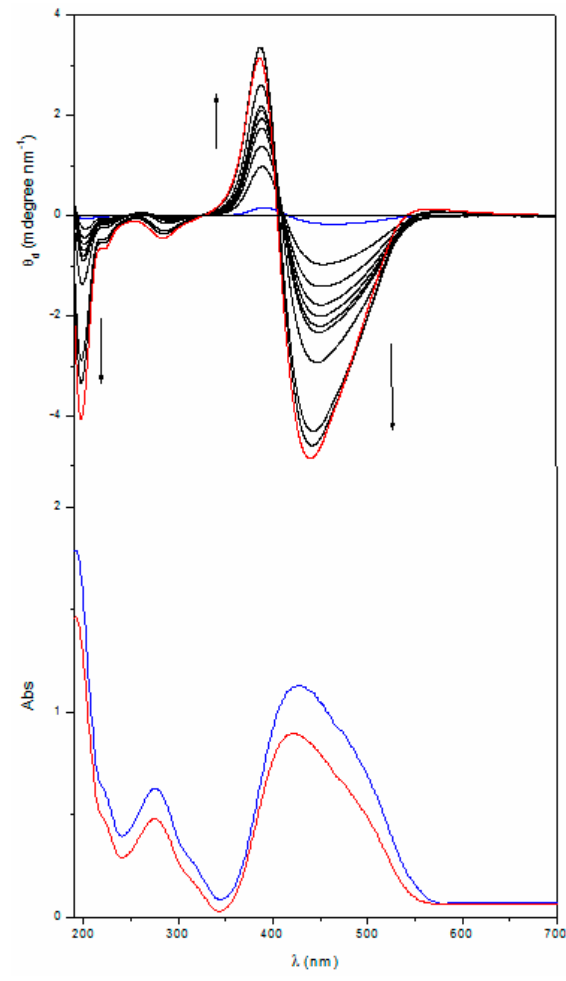
Figure 4. CD (up) and UV-vis (bottom) spectra of a 145 nm thick film of poly[( R )- MAP-C ] before (—) and after annealing at 200 °C for 5, 10, 15, 20, 25, 30, 40, 50, 60 (—) and 75 (—) min. CD spectra are normalized for the film thickness.